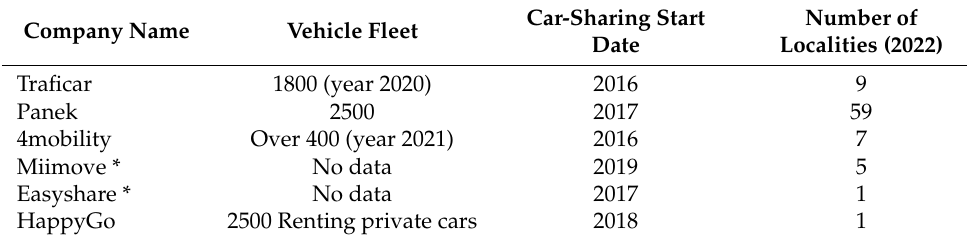
Figure 2. The market share of car-sharing service providers in Poland in 2021 [40]. Table 2. Characteristics of car-sharing services in Poland.